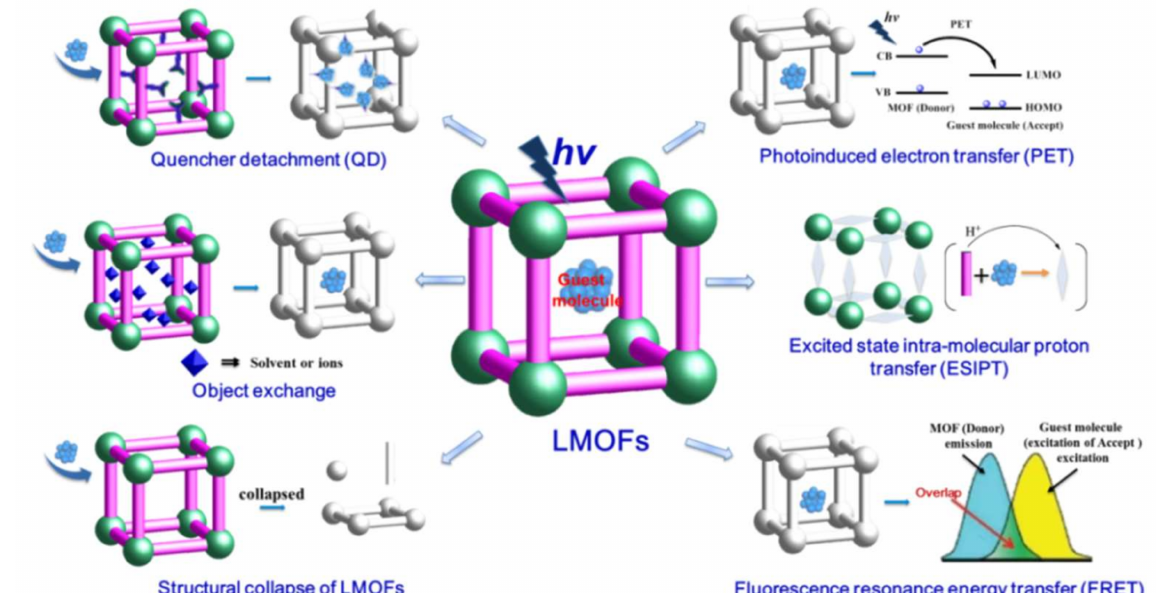
Figure 3. Detection mechanisms of